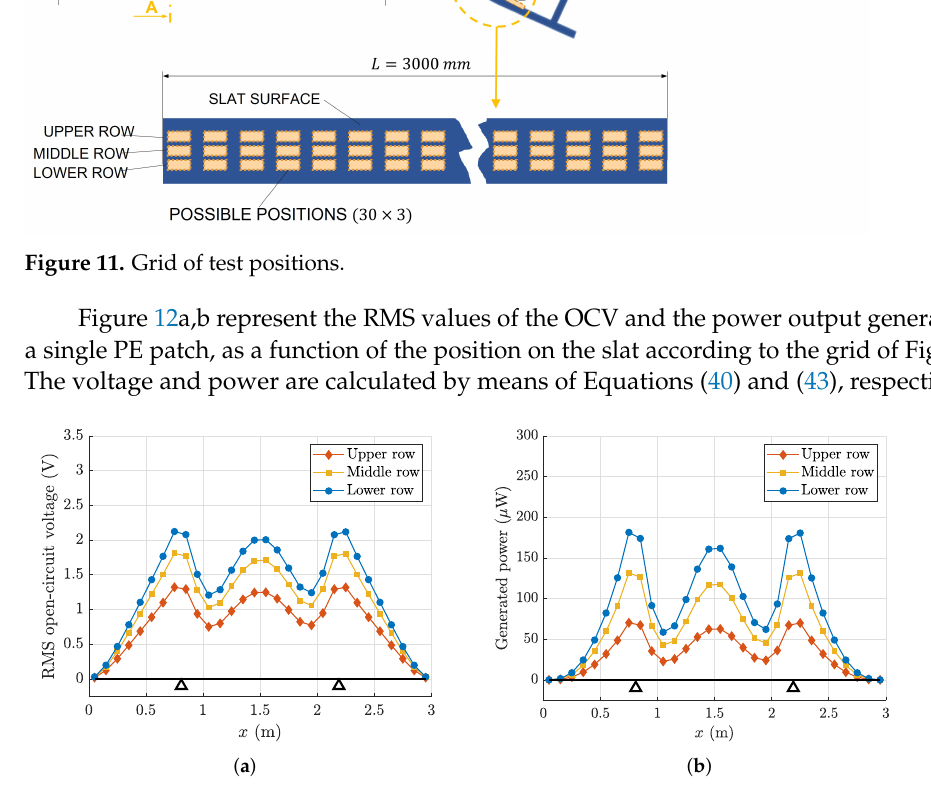
Figure 12. Performance of the PE patch directly attached to the surface of the slat. ( a ) RMS value of the OCV; ( b ) generated